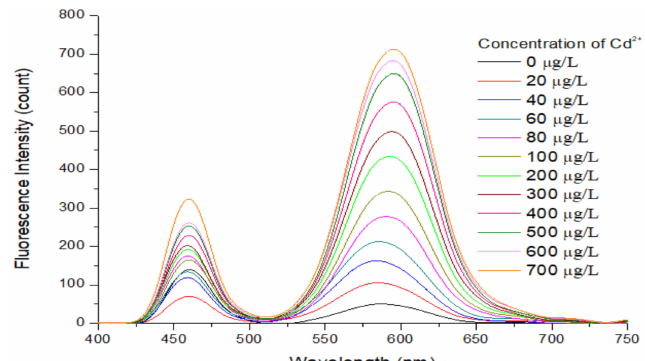
Figure 9. Relationship between the fluorescence intensity of the restored QD solution and the concentration of added Cd 2 + in the QD solution. Concentration of Tris-HCl bu ff er solution: 10 mmol / L. pH of Tris-HCl bu ff er solution: 8.5. Concentration of added QD solution: 5 µ mol / L. Concentration of APDC solution: 100 µ mol / L. Concentration of cadmium standard solution: 1 g / L. Addition order: Tris-HCl bu ff er solution (2 mL) → QD solution (0.4 mL) → APDC solution (0.52 mL) → cadmium standard solution (0–0.0028 mL) → Tris-HCl bu ff er solution (1.08–1.0772 mL). Excitation wavelength: 460 nm. Observation time: 3 min. All data in this figure is mean of five measurements.